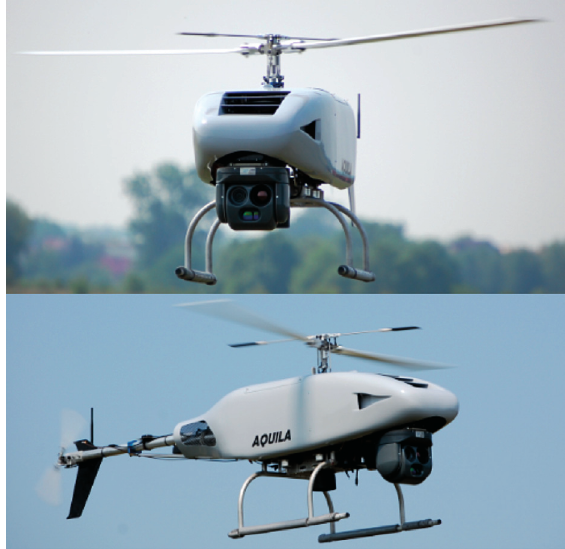
Fig. 5. The unmanned aircraft developed in the Faculty of